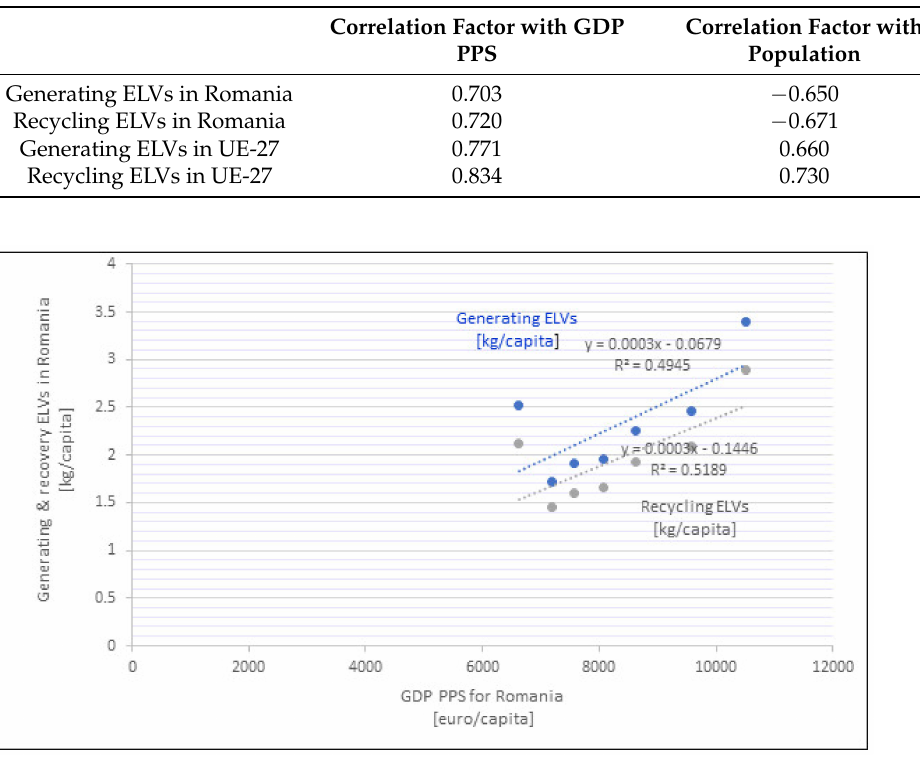
Table 11. Correlation coefficients between GDP-PPS and population number and generation, respec- tively recycling of ELVs in Romania and EU-27.